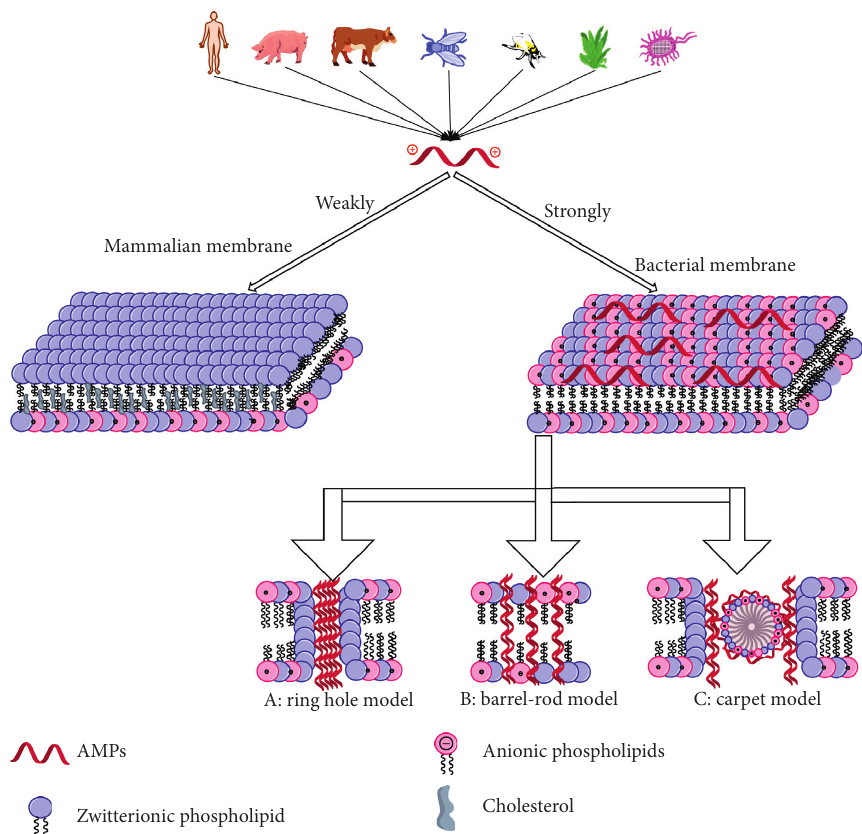
Figure 3: Mechanism of antibacterial peptides (AMPs): (a) in the ring hole model, the peptides insert into the membrane and aggregate into unstructured micelles by inducing continuous bending of the lipid monolayers; (b) in the barrel-rod model, the peptides vertically insert into the hydrophobic core region of the lipid membrane to form pores, like the rod inside the barrel; (c) in the carpet model, the peptides cover the membrane like a carpet, destroying the cell membrane and eventually leading to the formation of micelles. Due to the structural difference between the cell membrane of mammalian and bacterial, AMPs weakly react to mammalian cell membranes, but strongly to bacterial cell membranes.